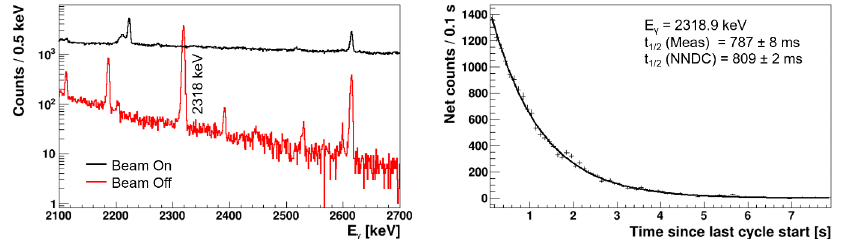
Figure 4. Measured γ -ray spectra showing the 2186.2 and 2318.9 keV transitions from the decay of 90 m Zr, and the resulting decay curve of the 2318.9 keV γ -ray